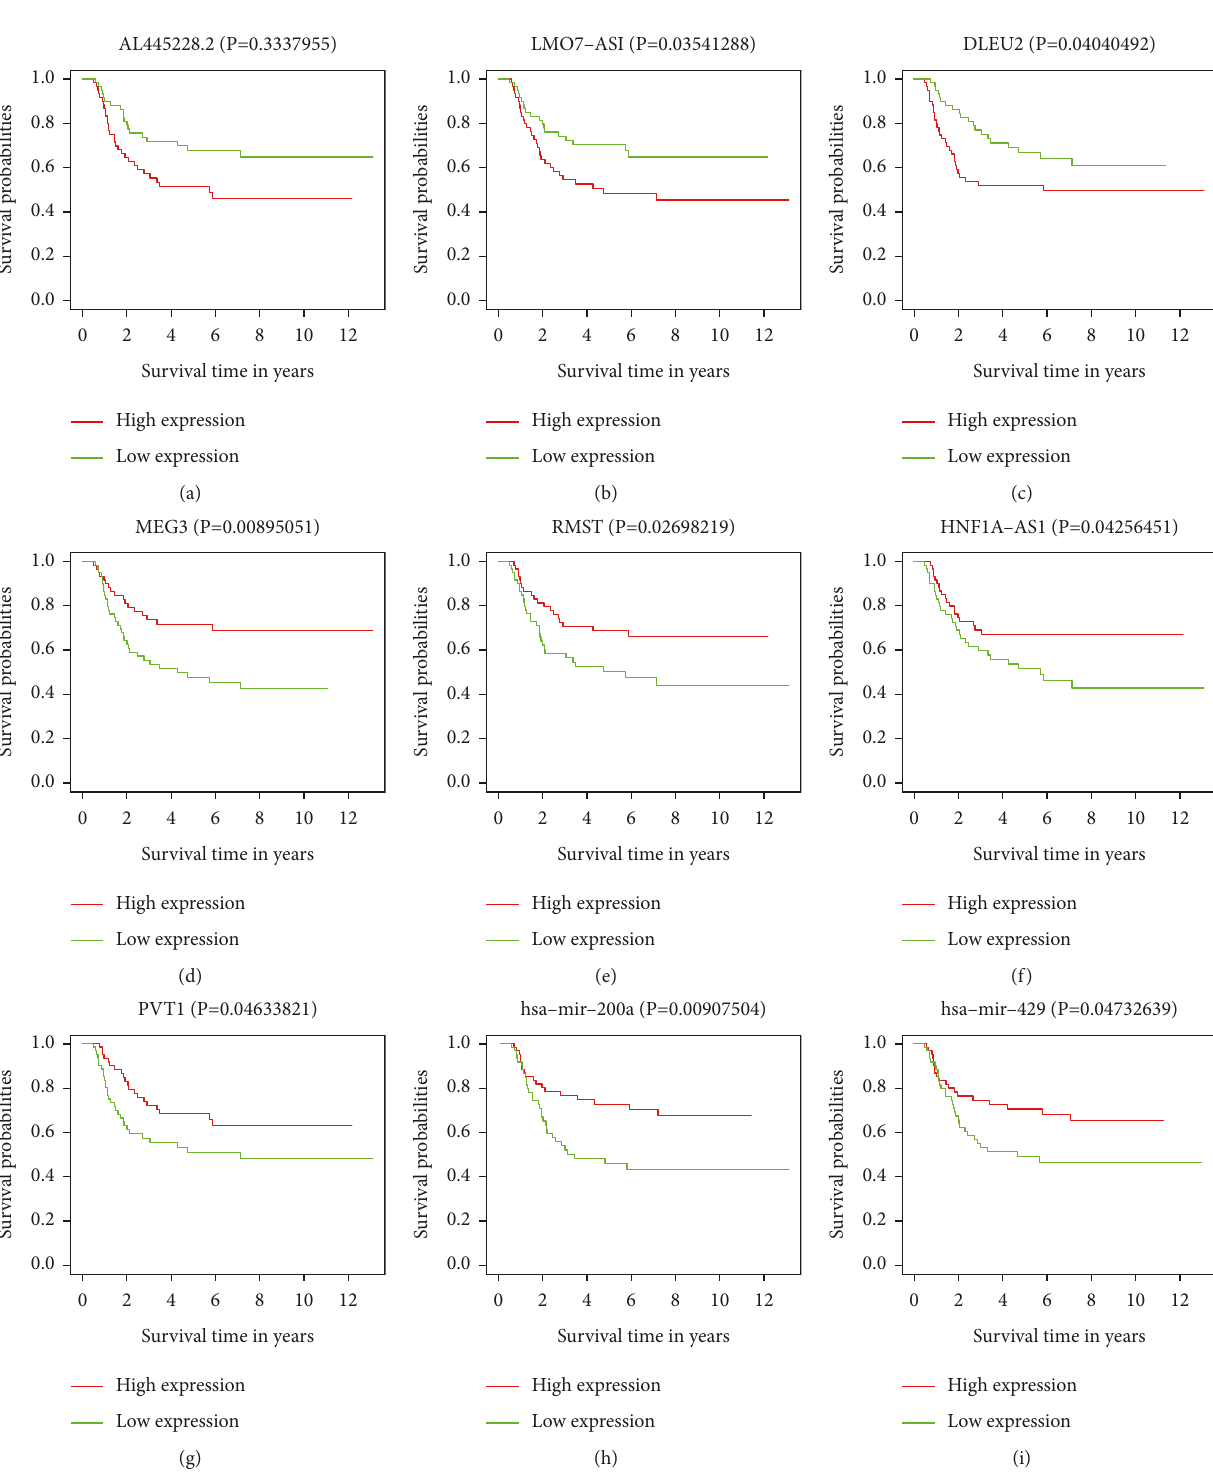
Figure 7: Kaplan–Meier survival curves for the prognosis-associated DERNAs. Kaplan–Meier survival curves for lncRNA (a) AL445228.2, (b) LMO7-AS1, (c) DLEU2, (d) MEG3, (e) RMST, (f) HNF1A-AS1 and (g) PVT1) and miRNAs (h) hsa-mir-429 and (i)